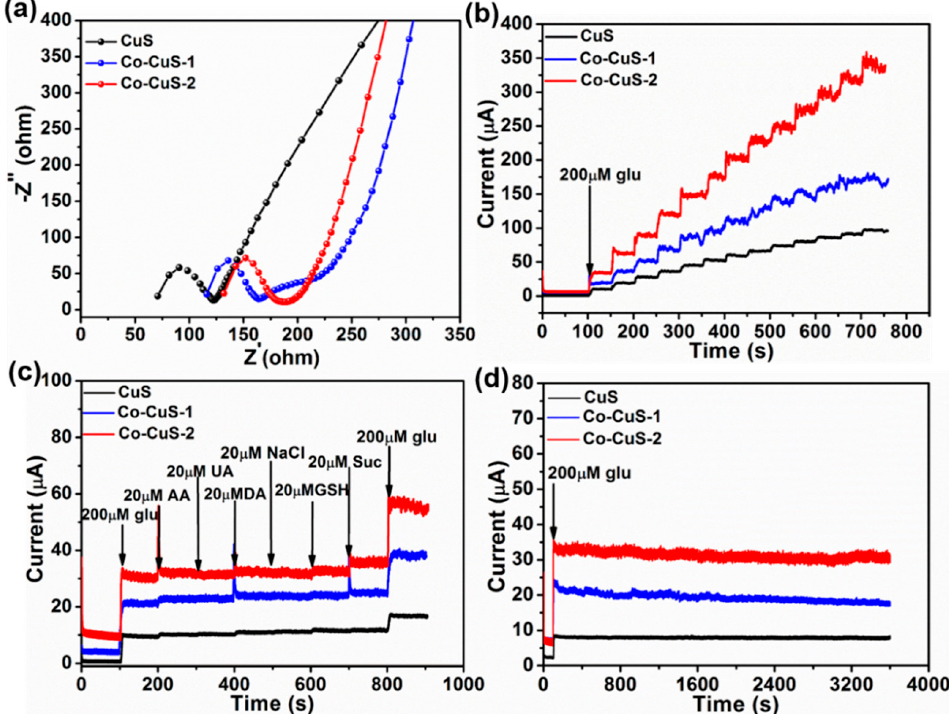
Figure 9. ( a ) Impedance diagram of CuS, Co-CuS-1 and Co-CuS-2 samples, ( b ) reproducibility, ( c ) anti-interference, and ( d ) stability. ( c ) anti-interference, and ( d )